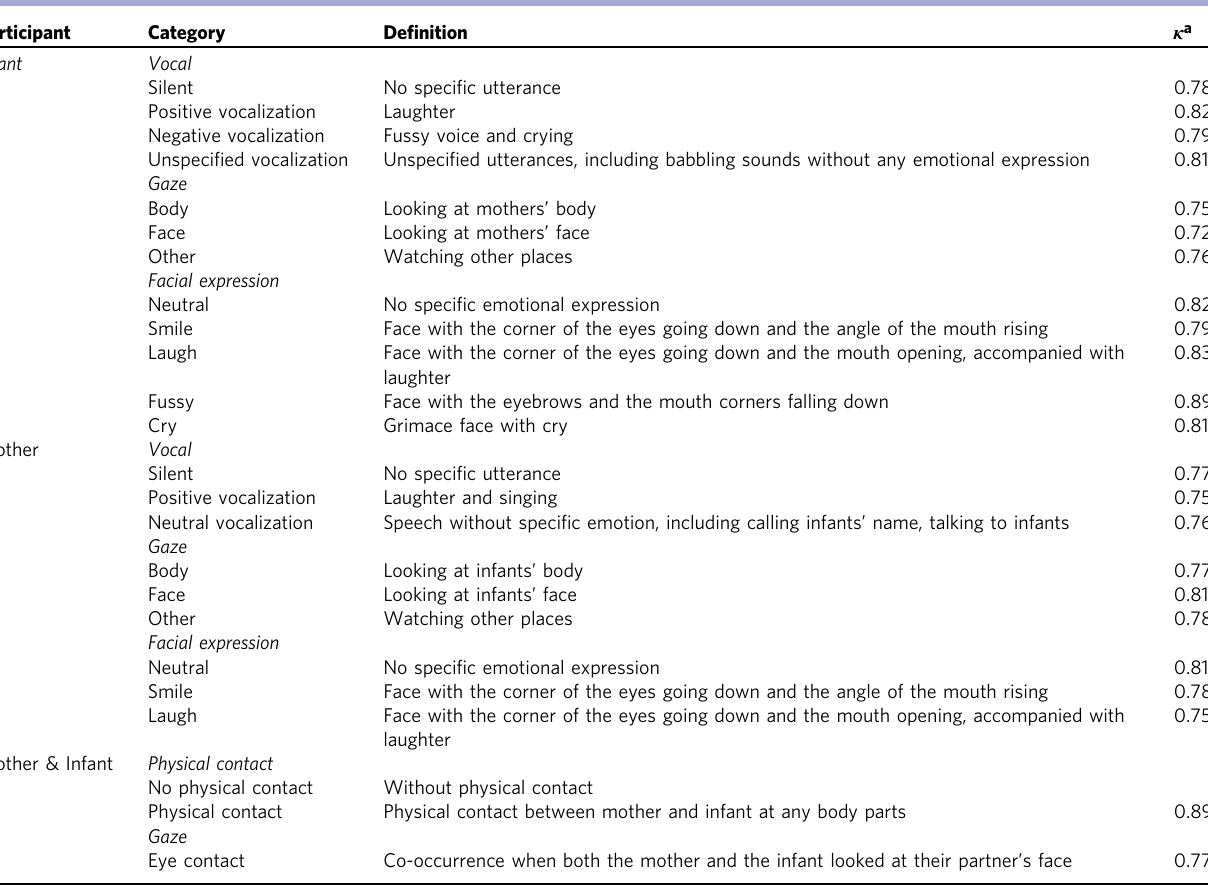
Table 1 Coding schema for mother – infant interaction.